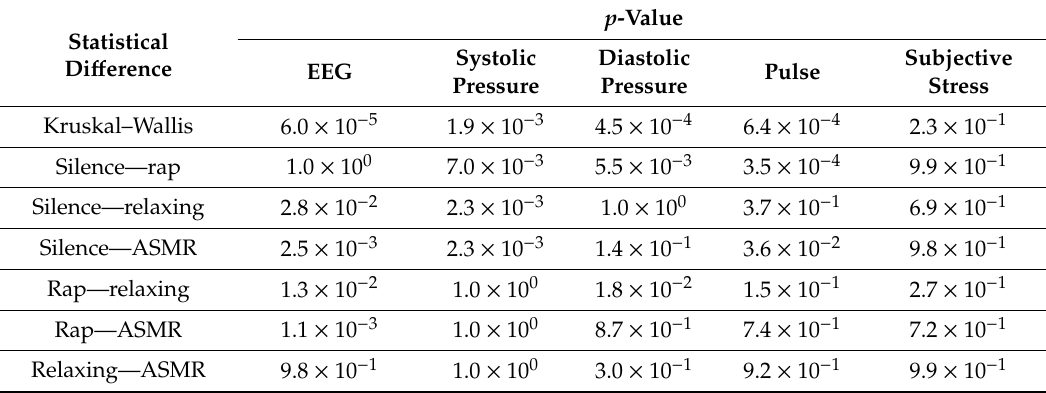
Table 5. The p -values of statistical hypotheses tests. The null hypothesis was that there is no significant di ff erence between compared